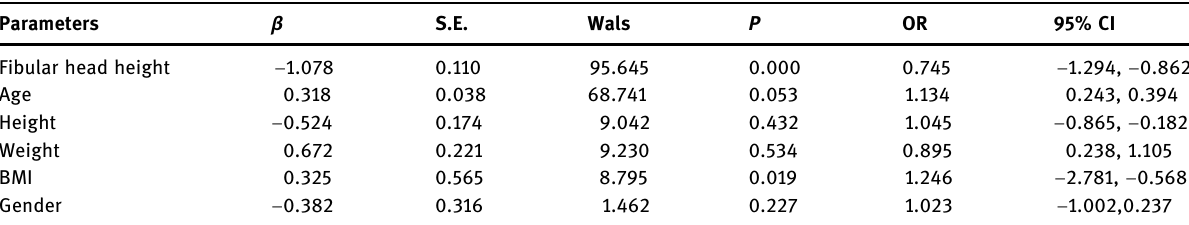
Table 3: Ordinal logistic regression with K – L grade as the dependent variable Parameters